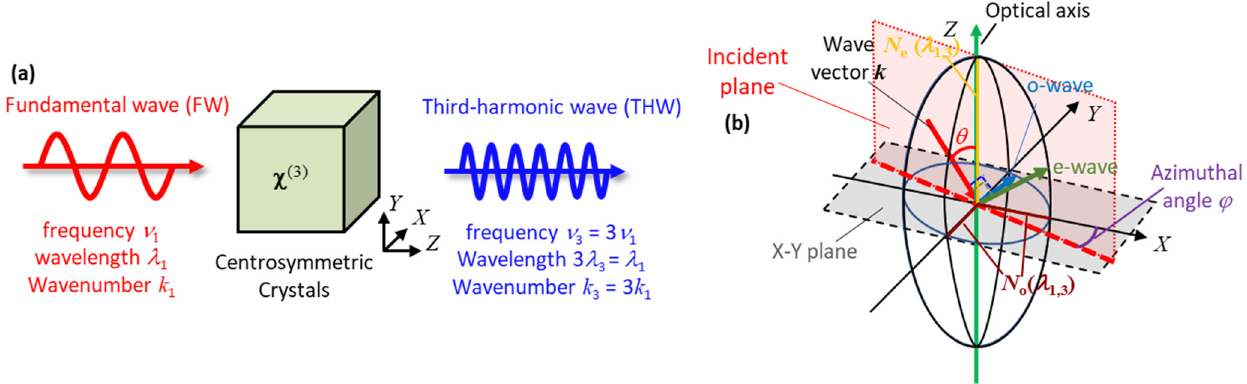
Figure 1. ( a ) The schematic of THG by χ (3) in centrosymmetric crystal; ( b ) The refractive index ellip- soid of uniaxial crystal. ellipsoid of uniaxial